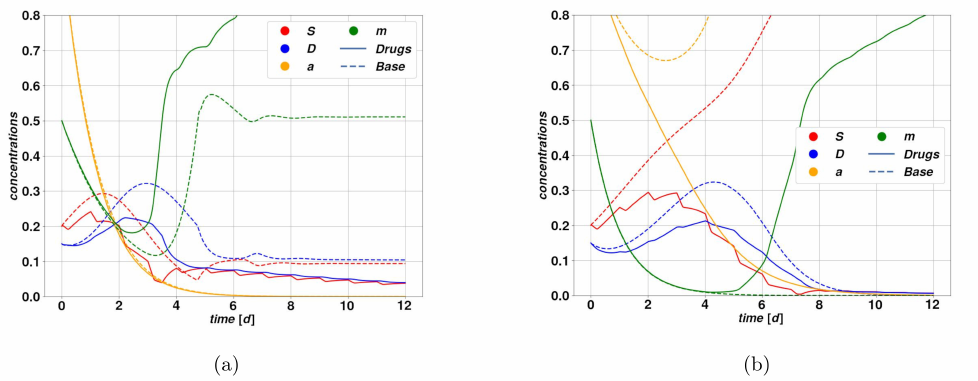
Figure 8. Trajectories of the system corresponding to the therapy combining a stimulated differenti- ation and a cytotoxic action (solid lines). The dashed trajectories correspond to the untreated case. We keep the same convention of colors as in the previous plots. Both plots ( a , b ) represent cases of effective treatments, under similar conditions as in Figure 7a and Figure 6a in order, respectively: in ( a ) the therapy breaks once again the feedback which produces the stable state associated with F 2 , while in ( b ) the therapy is able to bring under control and to complete regression of a tumor that would otherwise dangerously diverge. One can notice that the net effect of enhanced differentiation and increased DC death rate is an induced nonzero death rate for the CSCs. In these examples, we assumed the actions Ω dif f and Ω cyto to be equal in magnitude. The relevant parameter values can as usual be found in Tables